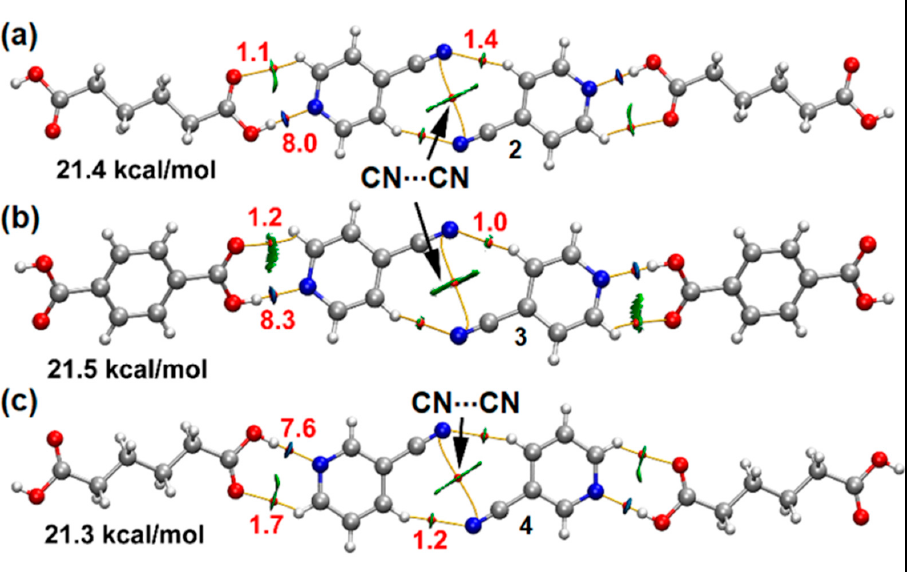
Figure 8. QTAIM and NCI plot analysis of the H-bonded assemblies of compounds 2 , 3 and 4 . The QTAIM energies are given in red for the H-bonds (in kcal/mol), and values in black correspond to the sum all the energies of all contacts.